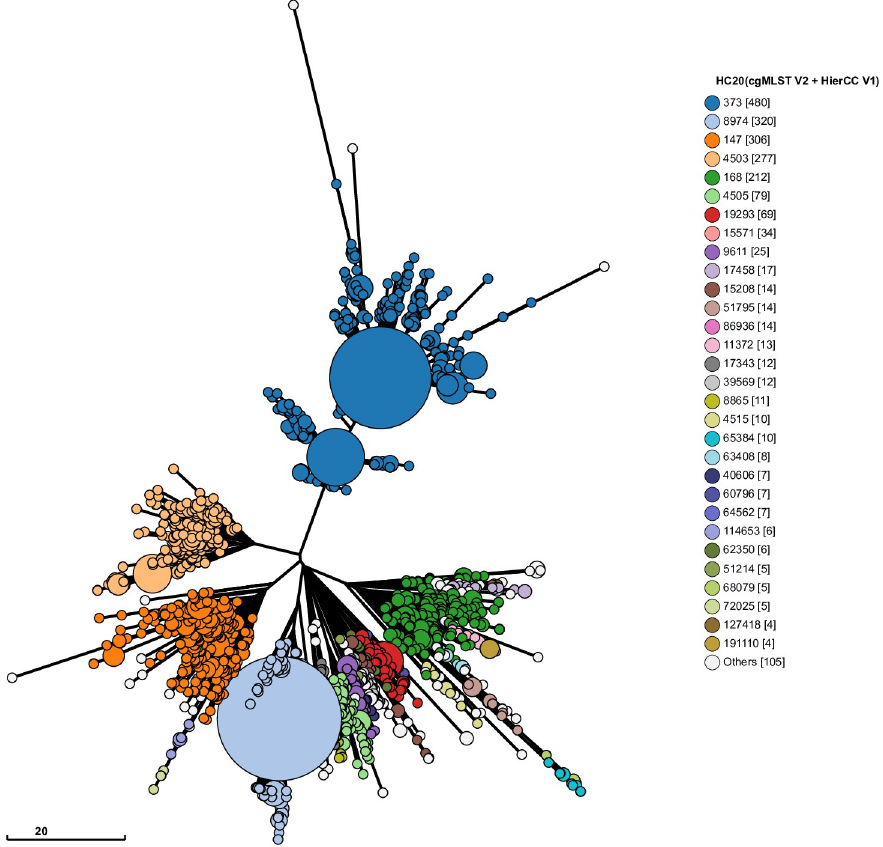
Fig 2. Neighbor Joining tree of allelic differences in genomes in HC50_147. Ninja NJ [64] visualization of allelic differences in the 3002 core genes of the cgMLST Salmonella scheme with GrapeTree [57]. At least 20 alleles differ between HC20_373 and all other HC20 clusters in the tree. The tree encompasses all 2098 HC50_147 genomes in EnteroBase on 1 December, 2020 at which time-point EnteroBase contained > 270,000 Salmonella genomes. An interactive plot of this data can be found together with additional metadata at http://enterobase.warwick.ac.uk/ms_ tree/50936.